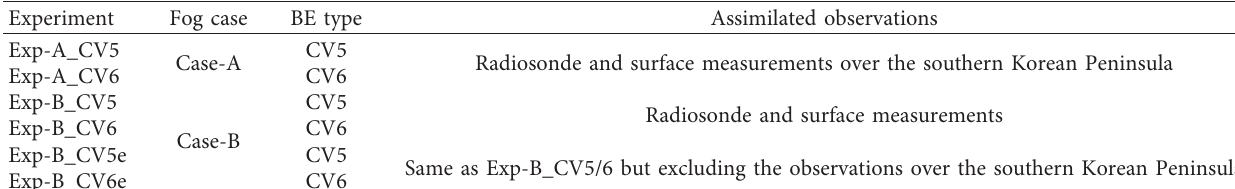
Figure 4: Geographic map of the two nesting domains of the weather research and forecasting (WRF) simulations for Case-A (a) and Case- B (b). Sites of surface (small dots) and upper-air (large dots) observations are indicated. The red dot in (a) is the observation location for single-observation experiments in Section 4.1, and the red dots in (b) are locations of upper-air observations for verification of Case-B. Table 2: Design of